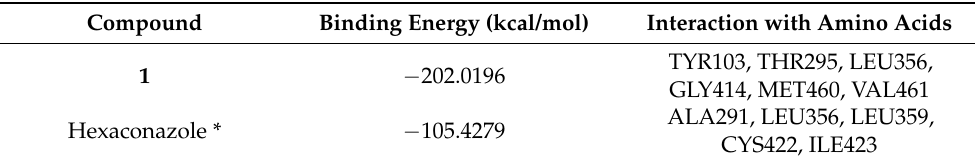
Figure 6. 2D and 3D images of oxalactam A ( 1 ) with the target protein CYP51 (Pink dotted lines: Pi-Alkyl interactions, light green dotted lines: Van Der Waals interactions, deep green dotted lines: Conventional hydrogen bond). Table 3. The interaction analysis of the molecular docking study on 14 α -demethylase CYP51 with oxalactam A ( 1 ) and